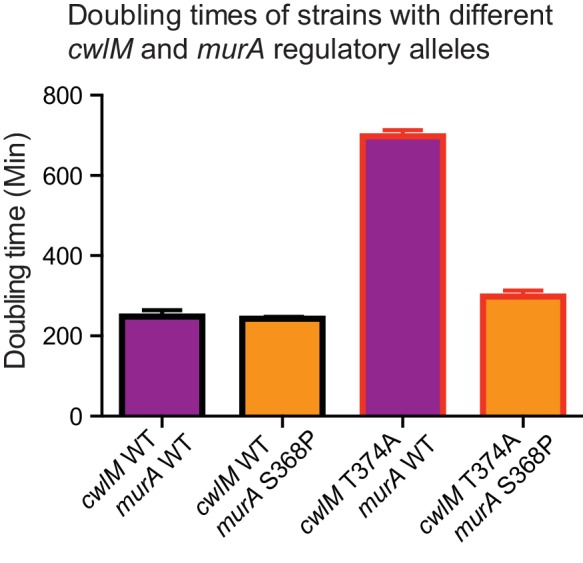
Growth rates of strains with different cwlM and murA regulatory alleles.Doubling times of strains. cwlM WT murA WT = CB779; cwlM WT murA S368P = CB782; cwlM T374A murA WT = CB319; cwlM T374A murA S368P = CB785. In the experiment described in Figure 4, we were not able to attain any cwlM T374A murA WT transformants, so the strain with this genotype is not isogenic with the other strains presented here. We were only able to attain colonies with the cwlM T374A murA WT genotype when the L5 allele swap was conducted in such a way that the correct swap was genetically forced. CB319 and the other strains presented in Figure 2 were made by using a parental strain (CB233) in which the only copy of cwlM was under the control of an Atc-inducible promoter on an L5 vector that contained the tetR gene: this strain is Atc-dependent, because TetR will repress transcription of cwlM unless Atc is added. The alternate alleles of cwlM were under the control of Atc-inducible promoter on L5-integrating vectors that do not contain the tetR gene; they were transformed into CB233 and plated on plates that do not contain Atc. If the original L5 vector remains at the L5 site in addition to the new vector with the alternate allele, the TetR expressed from the original vector will repress transcription of both alleles of cwlM and cause cell death: thus, the loss of the original vector is forced, and we were able to recover colonies even with very slow growth rates. In the transformations described in Figure 4, resulting in strains CB779, 782 and 785, there was no tetR on either of the L5 vectors; thus, the swap was not forced, and at least half of the colonies from any transformation had both the original L5 vector with WT cwlM and the newly-transformed vector.